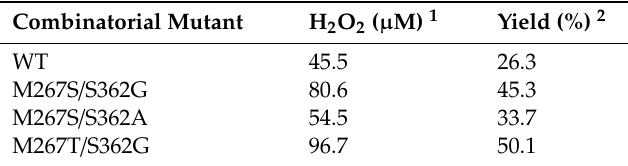
Figure 4. Comparison of the wild type and the mutants on catalytic performance of alcohol oxidation. The reaction mixture (5 mL) contained 10 mg crude enzyme, 100 mM methyl glycolate, 0.01 mM FMN and 50 mM Tris-HCl (pH 8.0). The reaction at an oxygen aeration rate of 1 L/h was carried out at 25 °C and 600 rpm for 8 h. Table 3. Comparison of the wild type and its double-substitution variants on the concentration of evolved H 2 O 2 and catalytic performance of alcohol oxidation.